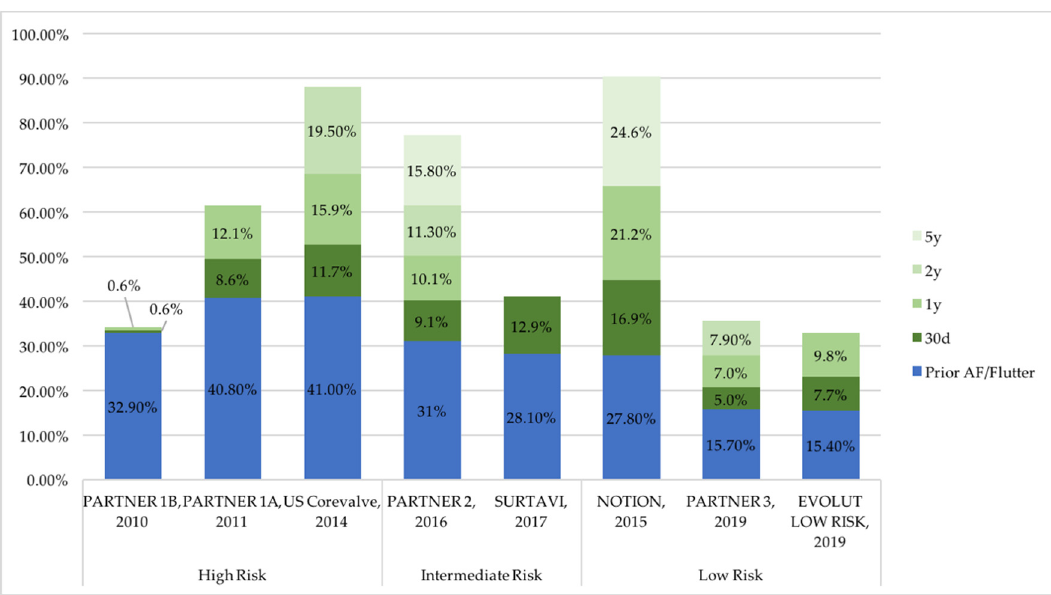
Figure 3. Reported incidences of prior or new onset of atrial fibrillation (AF) after transcatheter aortic valve replacement in pivot trials. NOTION: Nordic Aortic Valve Intervention Trial; PARTNER: Placement of Aortic Transcatheter Valve; SURTAVI: Safety and Efficacy Study of the Medtronic Corevalve© System in the Treatment of Severe, Symptomatic Aortic Stenosis in Intermediate Risk Subjects Who Need Aortic Valve Replacement.